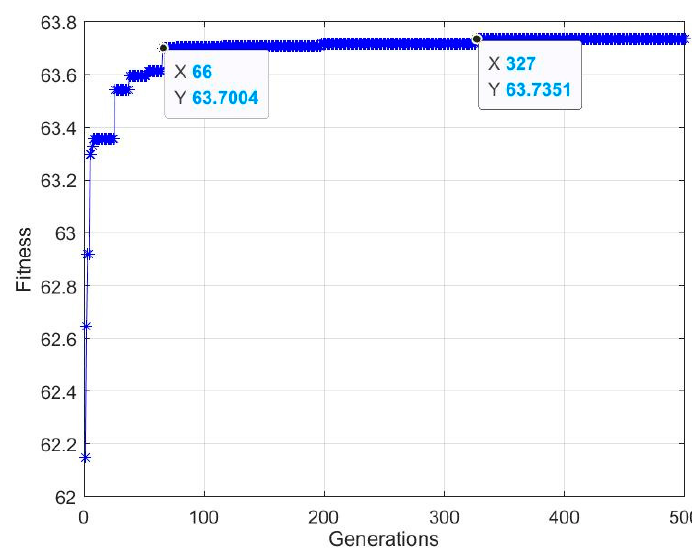
Figure 13. Evolvement of fitness with 500 generations.